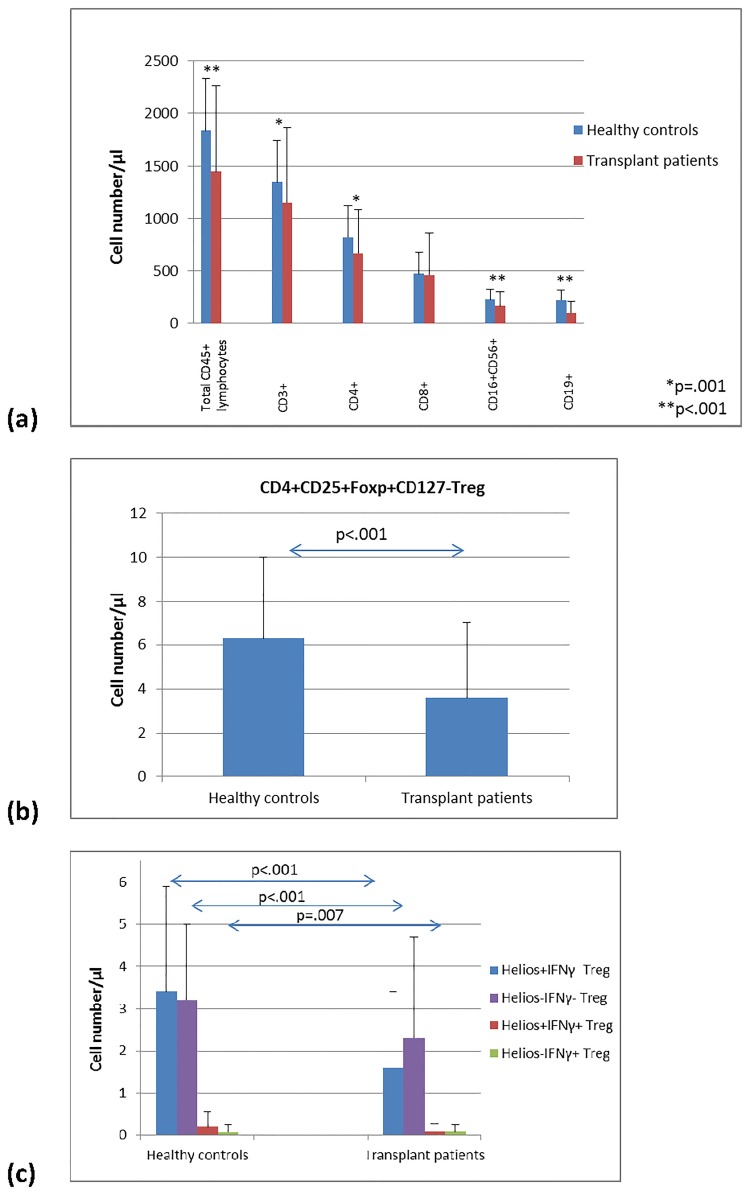
Lymphocyte and Treg subsets in long-term stable kidney transplant recipients.Long-term stable kidney transplant recipients (n = 136) have lower absolute counts of (a) CD45+, CD3+, CD4, CD16+56+ and CD19+ lymphocytes, (b) CD4+CD25+Foxp3+CD127- Treg and (c) Helios+IFNy-, Helios-IFNy- and Helios+IFNy+ Treg subsets than healthy controls (n = 52) (all p<0.01, Mann-Whitney U test). Data are given as mean±SD.